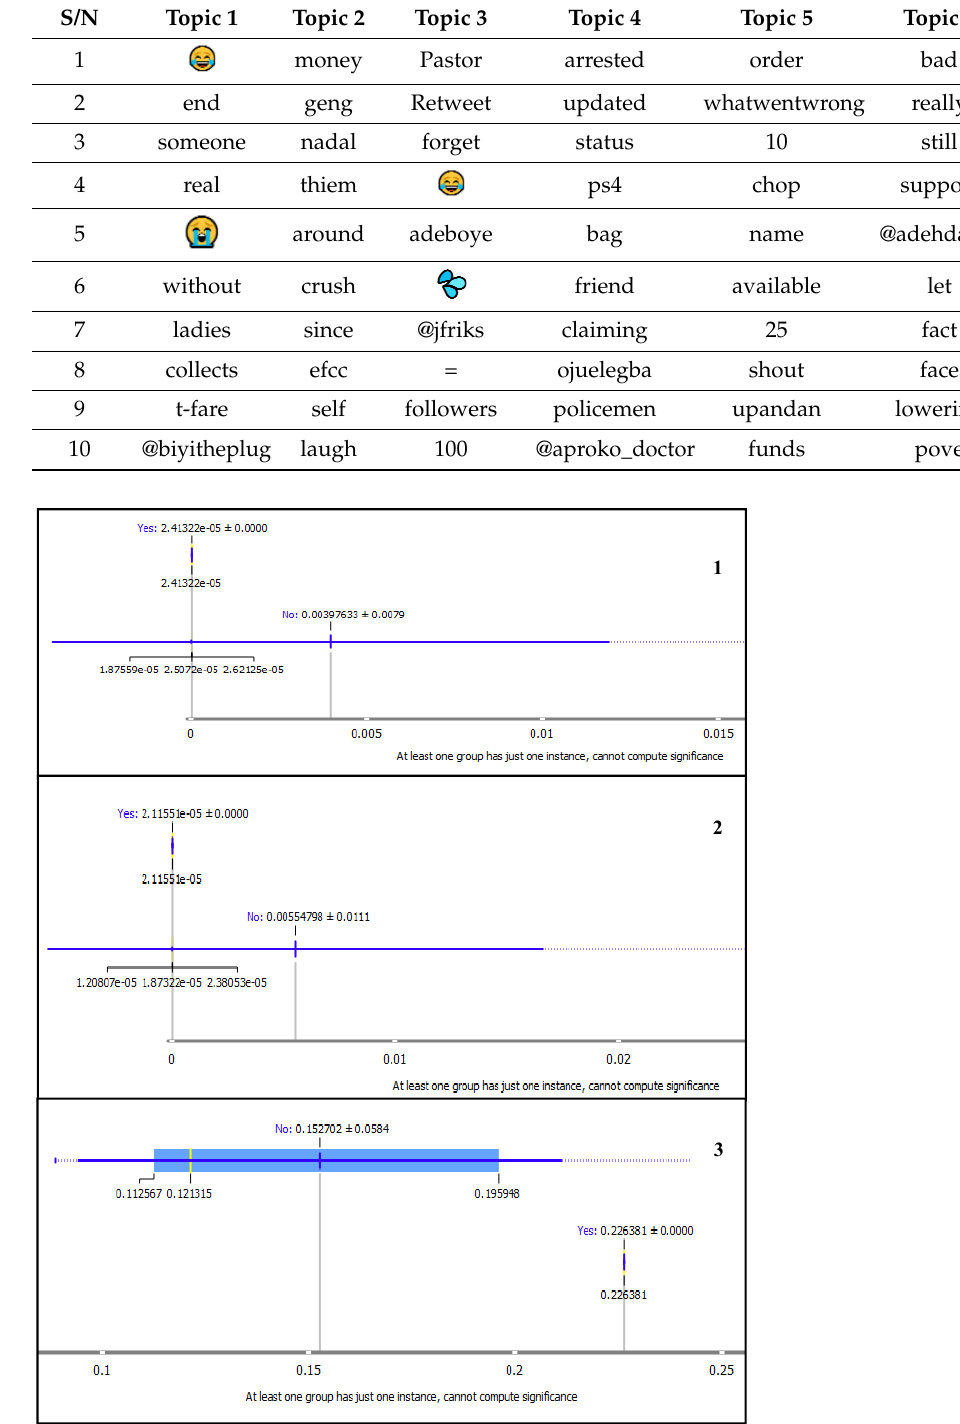
Table 7. Top ten words by order of relevance to the topic in the corpus extracted from the box plot.